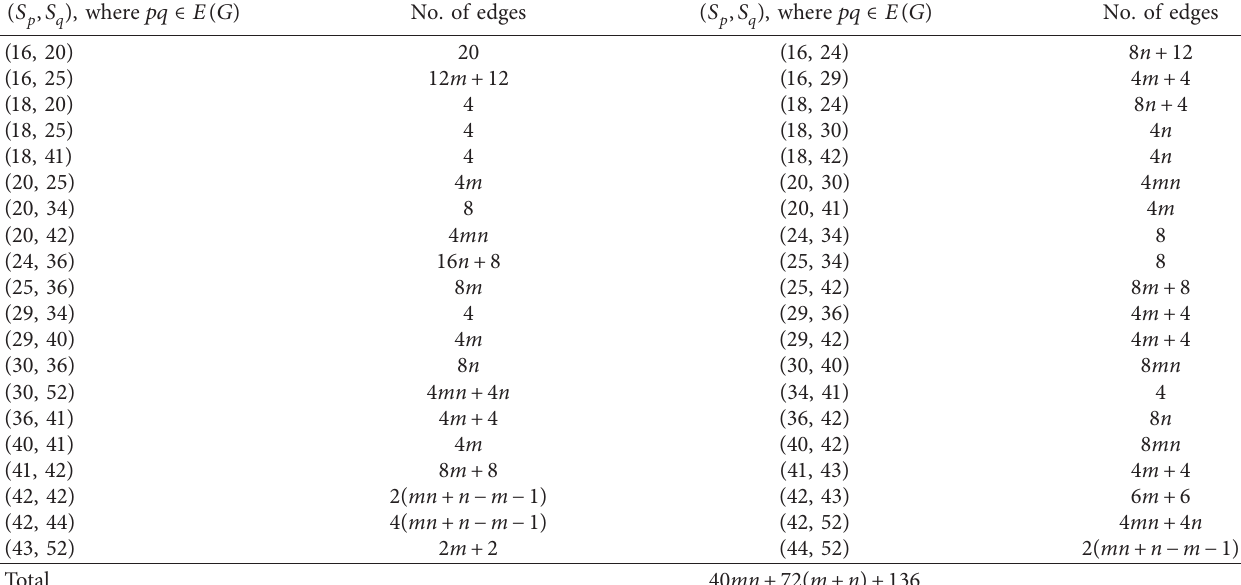
Table 3: The line division of neighbors of ( m , n ) Robertson apex